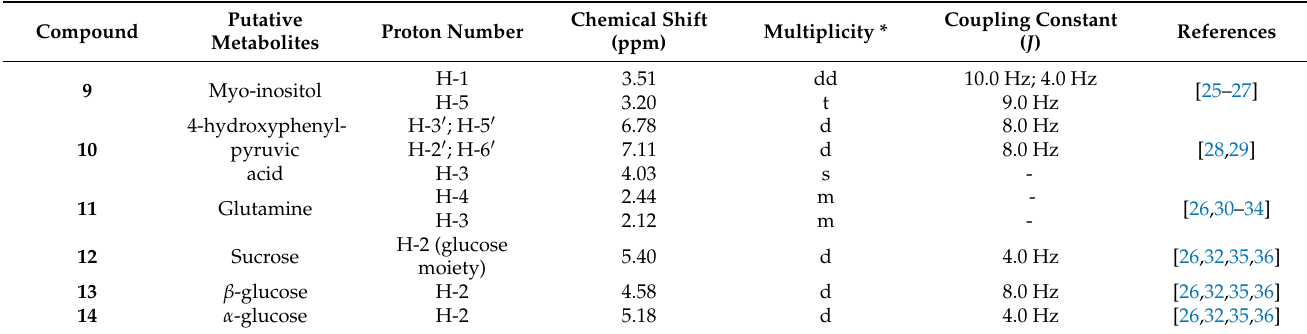
Table 6. The 1 H-NMR chemical shifts, proton number, multiplicity, and coupling constant of the identified compounds in Psychotria malayana extract.